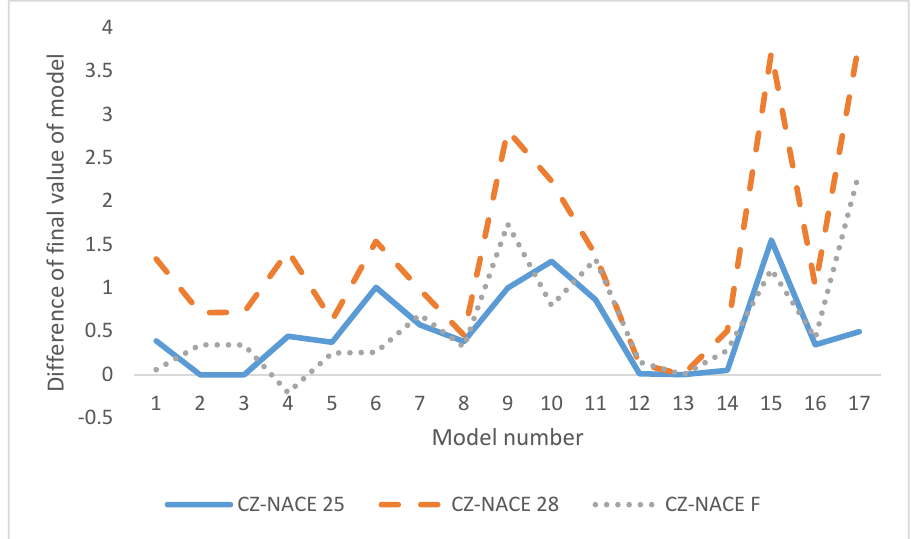
Figure 4. Absolute differences of the model indicators for insolvent companies regarding 2012 and 2017 by branches. Source: authors’ own work.